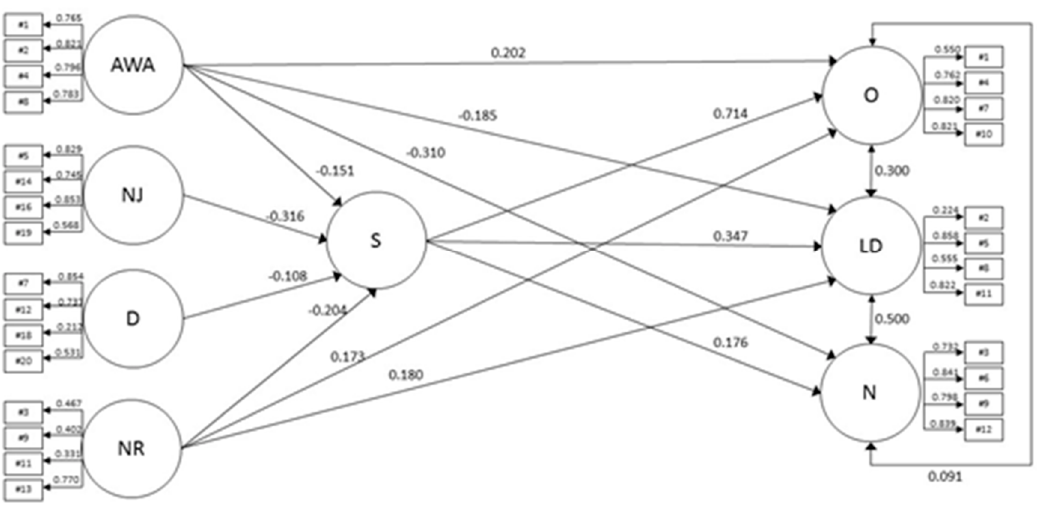
Figure 1. Structural equation model for mindfulness facets, perceived stress dimensions, and burnout subtypes. Note. Circles represent latent constructs and rectangles observable variables. Standardized factor weights are over the arrows. AWA = Acting with awareness; D = Describing; LD = Lack of development; O = Overload; N = Neglect; NJ = Non-judging; NR = Non-reacting. For clarity, non-significant pathways between latent variables were not shown. Factor loadings of items on general perceived stress factor (with λ s ranging from 0.185 [#4] to 0.768 [#20]; all p < 0.001), correlations between mindfulness facets and a second-order mindfulness factor ( rAWA = 0.621, rNJ = 0.707, rD = 0.648, rNR = 0.314; all p < 0.001), and correlation between error terms between items #18 and #20 within D ( r = 0.400, p < 0.001) and between items #2 and #8 within LD ( r = 0.562, p < 0.001) were not shown for the same